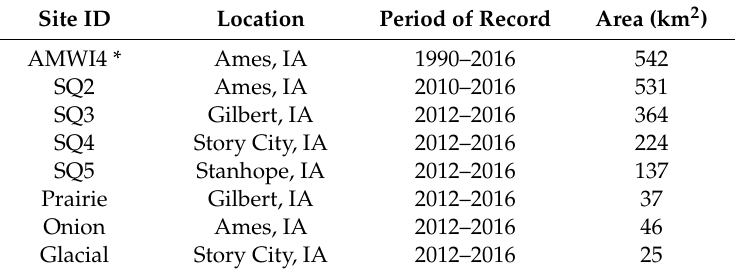
Table 1. Squaw Creek basin and subbasins gage sites. The outlet of Squaw Creek watershed, denoted with “*”, has United States Geological Survey station ID 05470500 and US National Weather Service ID AMWI4.